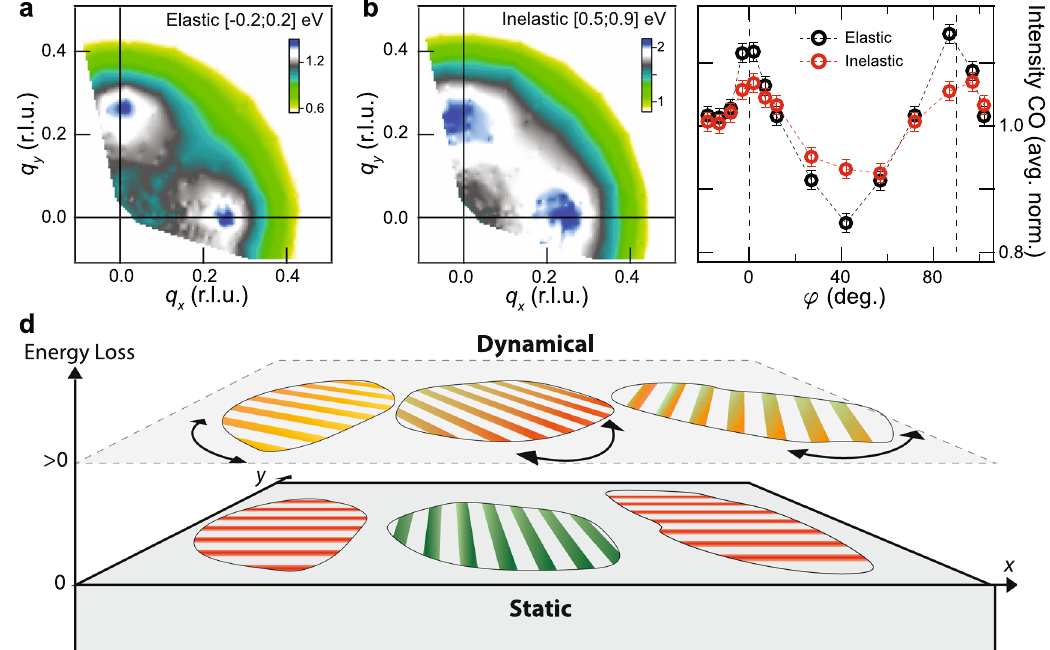
Fig. 2 The effect of lattice symmetry in locking short-range static charge order. a Static charge order (CO) structure showing well-de fi ned peaks locked along q x and q y . b Dynamic charge correlations showing the ring-like structure. c Scattering intensity at q ¼ q = q CO obtained from ( a ) and ( b ), and normalized to their respective averages. The error bars in ( c ) represent the systematic errors associated with the experiment (see Supplementary Note 2). d Schematic of CO fl uctuations: static short-range CO domains are allowed to dynamically fl uctuate into any in-plane